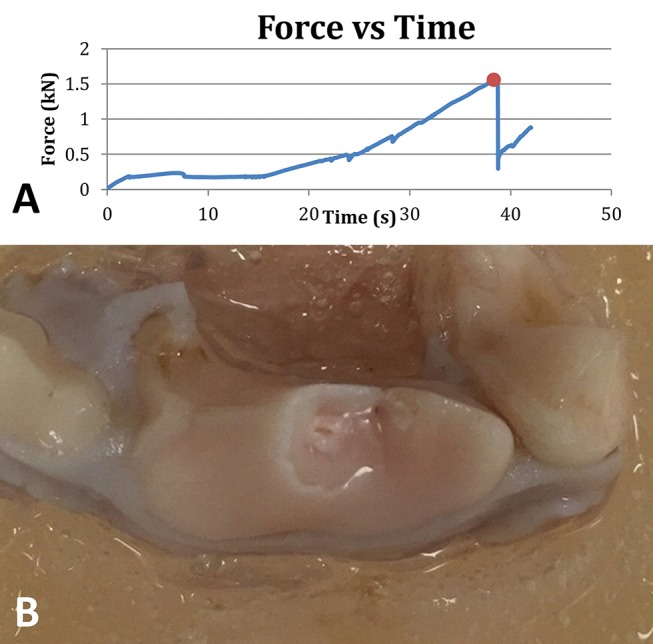
A representative plot of the force applied to a tooth as a function of time. The ultimate force before instantaneous failure is denoted with a red dot (A). Right maxillary fourth premolar tooth showing a complicated crown fracture (i.e., with pulp exposure) following mechanical testing (B).